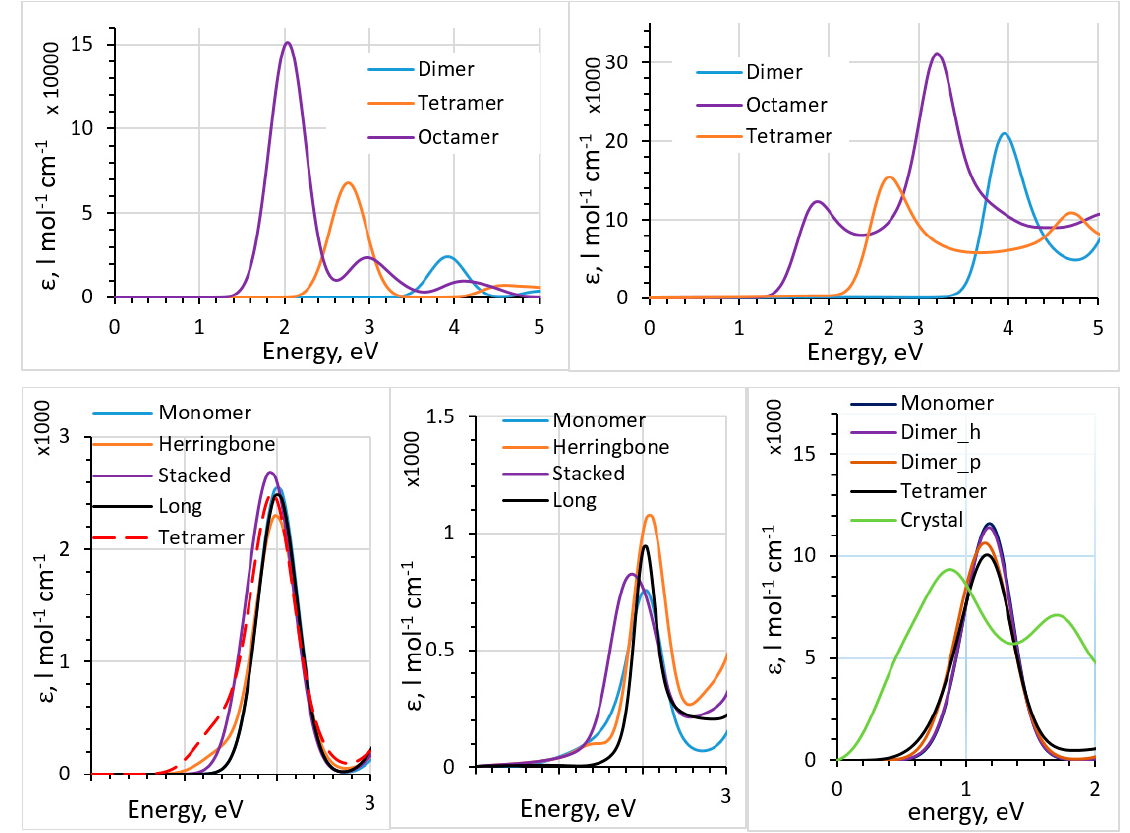
Figure 3. Top: absorption spectra of thiophene oligomers computed with TD-DFT (top left) and the polarizability-based method (top right), with B3LYP functional. Bottom: absorption spectra of different pentacene clusters (see [44] for definitions of the clusters) cut out of the crystal structure computed with TD-DFT (bottom left) and the polarizability-based method (bottom middle), with B3LYP functional. Bottom right: absorption spectra of solid pentacene and different pentacene clusters cut out of the crystal structure computed with the dipole approximation, with PBE functional. See [44] for details. Reproduced from Ref. 44, with the permission of AIP Publishing.